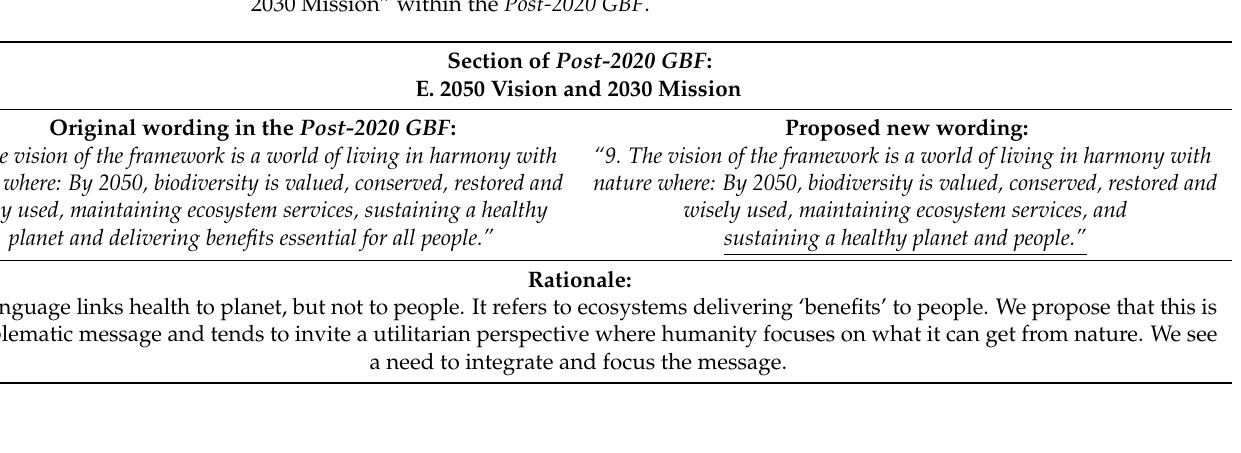
Table 2. Suggested revised health-inclusion statement and rationale for “Section E. 2050 Vision